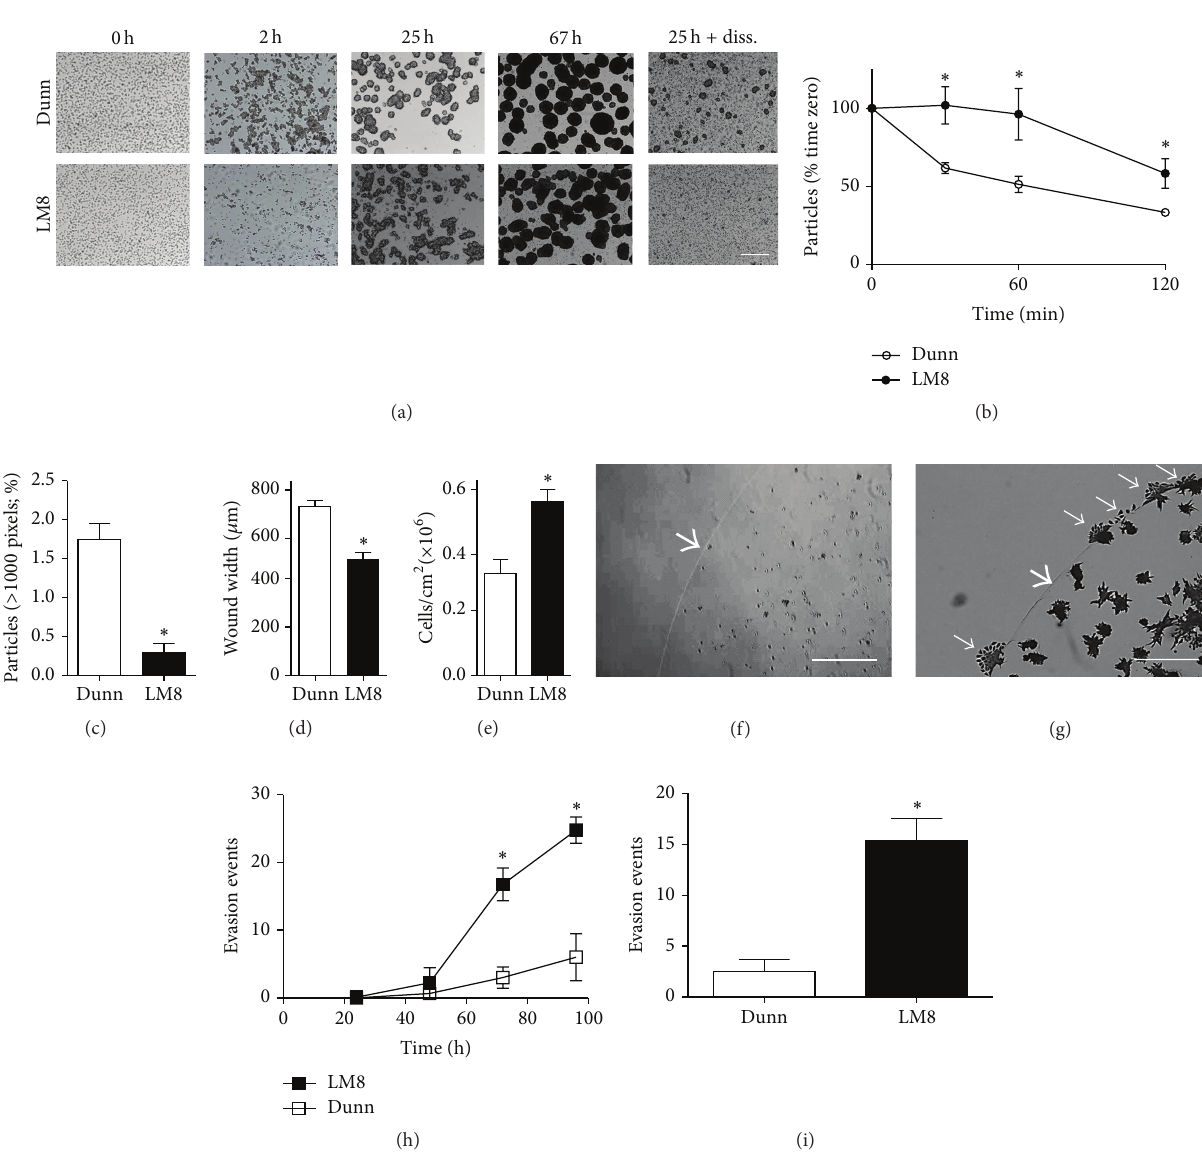
Figure 1: Intercellular adhesion, contact inhibition, and invasiveness of Dunn and LM8 cells in vitro . (a) Representative time course of intercellular adhesion and dissociation of Dunn (upper panels) and LM8 (lower panels). Scale bar: 400 𝜇 m. (b) Quantification of particle number in percent of the 0min value. Particle numbers at time zero were 1036±105 and 1313±93 ( 𝑃 > 0.05 ) in Dunn and LM8, respectively, and were set to 100%. (c) Dissociation by pipetting after 25 h association. Results are the means ± SEM of 3 independent experiments. (d) Intercellular adhesion was further estimated by wounding of confluent cells grown in 24-well plates with a pen and subsequent measurement of the width of the fresh wound as described in Section 2. (e) The cells were grown in 25 cm 2 flasks to visual confluence and then trypsinized and counted to estimate differences in contact inhibition. The invasive activity of cells in vitro was determined in a three-dimensional Matrigel degradation and migration assay. Representative microscopic images of LM8 cells seeded in Matrigel drops (500 cells/ 𝜇 L) immediately after gelling (f) and after incubation for 72h in cell culture medium (g) are shown (scale bars in (f) and (g): 500 𝜇 m). Bold arrows in (f) and (g) point to the border of the Matrigel drop, and normal arrows in (g) to foci evading from the Matrigel drop from cell clusters growing inside the Matrigel drop. (h) The number of foci evading from the Matrigel drops ( 𝑛 = 3 ) was counted daily. (i) The difference between the numbers of Matrigel-evading Dunn and LM8 cell foci per drop ( 𝑛 = 4 ) peaked at 72 h after cell seeding. All results are shown as the means ± SEM of 3–6 independent experiments. Asterisks ( ∗ ) indicate statistically significant difference ( 𝑃 < 0.05